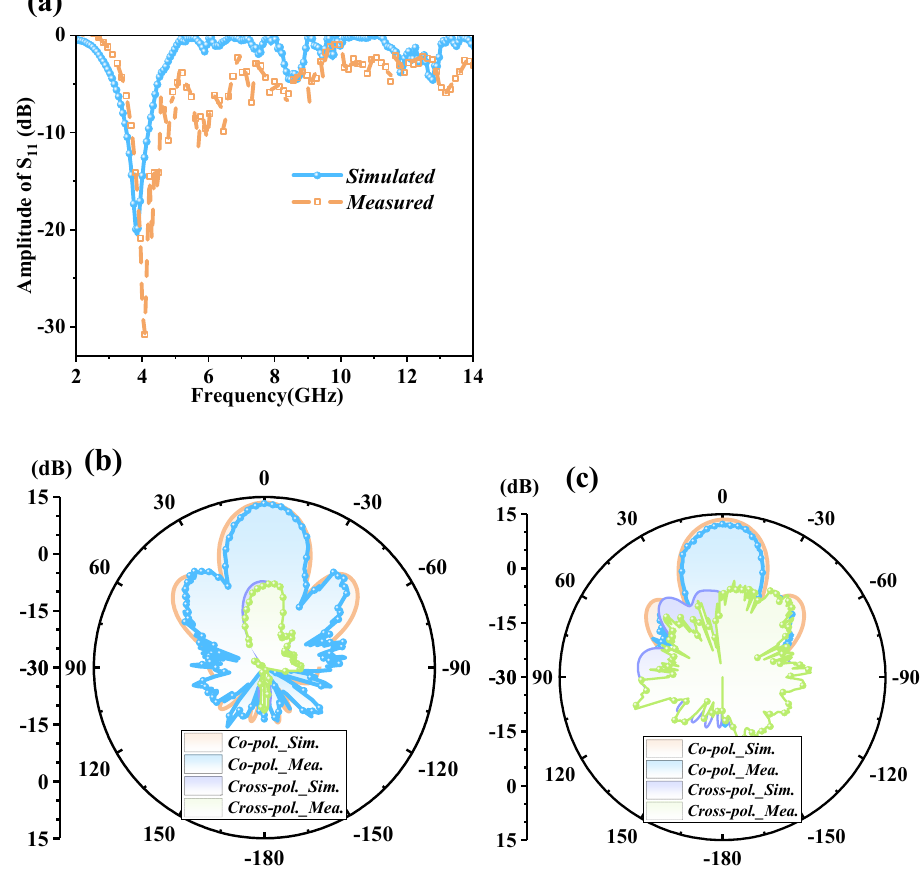
Figure 8. Measured and simulated amplitudes of S 11 and radiation patterns at 4 GHz for the CFMS. ( a ) Measured and simulated amplitudes of S 11 for the CFMS. ( b ) Co- and cross-polarized radiation patterns on the E-plane. ( c ) Co- and cross-polarized radiation patterns on the H-plane.